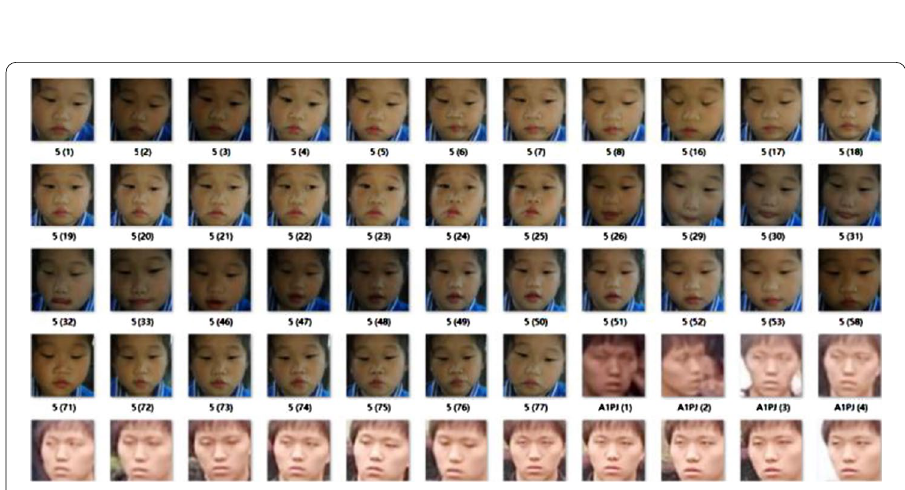
Fig. 7 The training set of the expression recognition